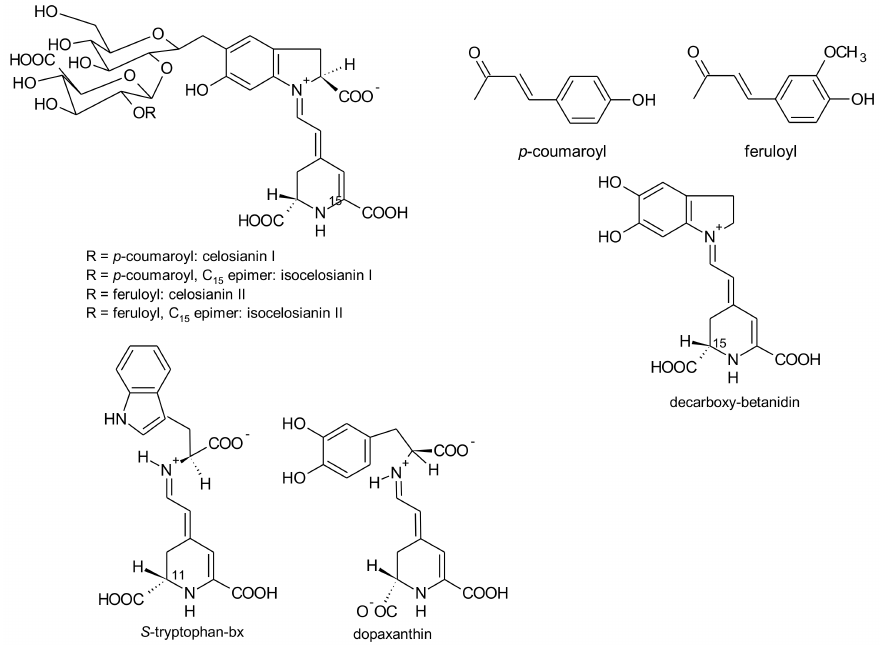
Figure 9. Celosianins, dihydroxylated betalains and S -tryptophan-bx from Celosia